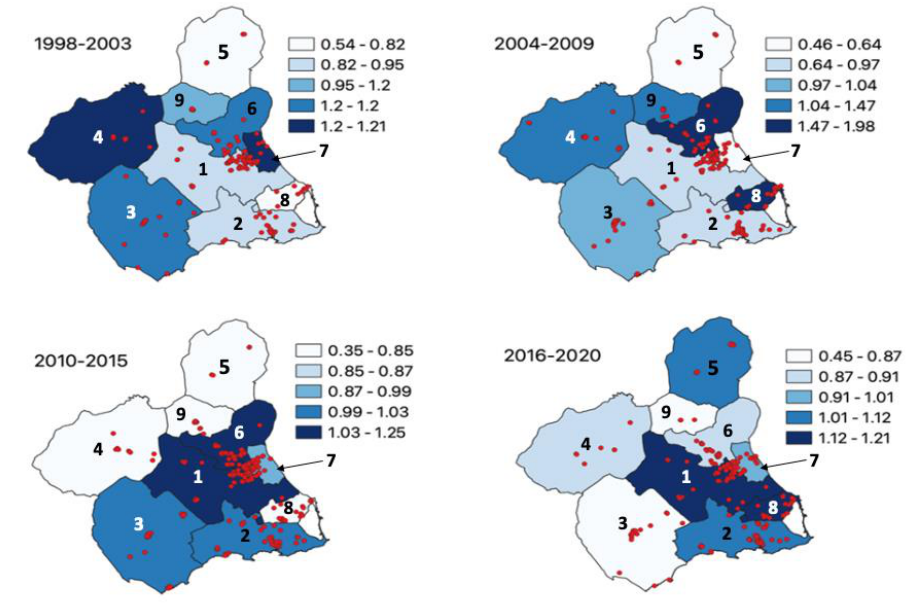
Figure 5. SIR by health areas and time cohort in the region of Murcia, 1998–2020 (n = 822).